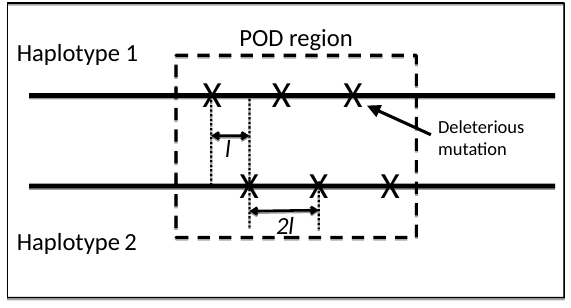
Figure 1 – Genetic structure of the POD region (delimited by the dashed box). Deleteri- ous mutations (represented by crosses) linked in cis occur at a distance 2 ℓ M from each other along the same chromosome, alternating (at a distance ℓ M) with trans mutations on the opposite chromosome. Close, regular, and alternating spacing of recessive delete- rious mutations along both haplotypes ensure linkage and